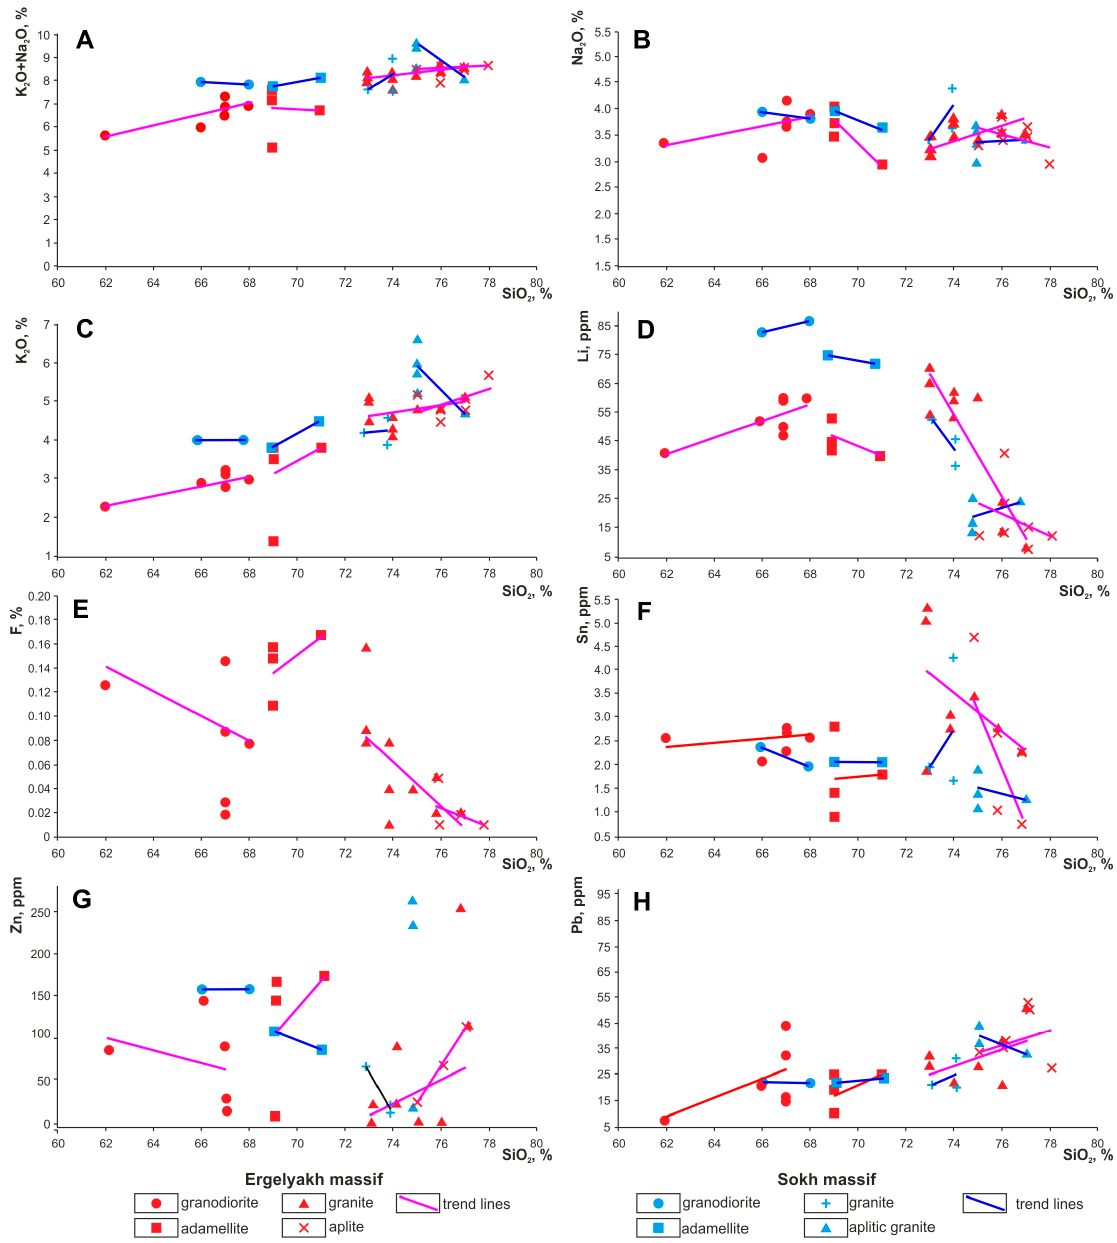
Figure 5. Variation diagrams for granitoids of Ergelyakh and Sokh massifs: ( A ) K 2 O + Na 2 O–SiO 2 ; ( B ) Na 2 O–SiO 2 ; ( C ) K 2 O–SiO 2 ; ( D ) F–SiO 2 ; ( E ) Li–SiO 2 ; ( F ) Sn–SiO 2 ; ( G ) Zn–SiO 2 ; ( H ) Pb–SiO 2